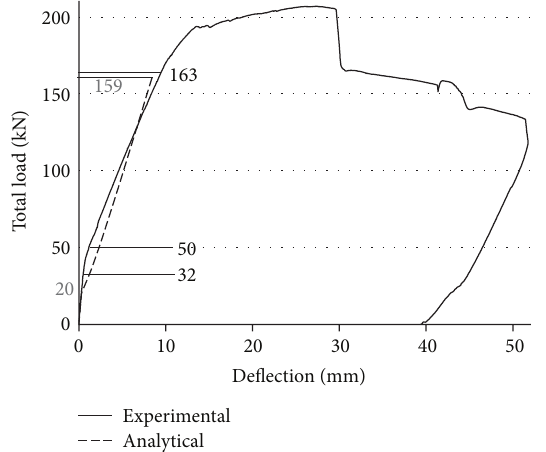
Figure 5: Analytical and experimental load-deflection curves of compositebeamwithlongitudinalsteelreinforcementandHPFRCC IPC formwork as shear reinforcement.